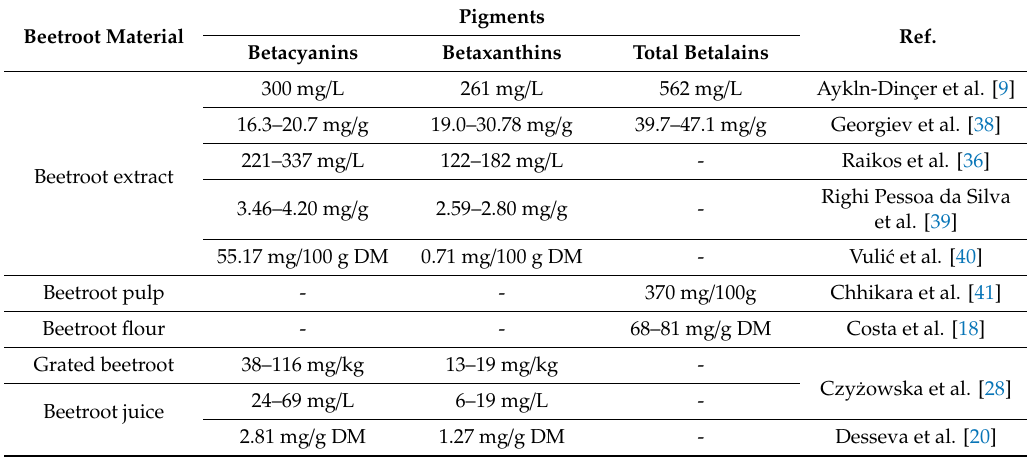
Table 1. Content of total betalains, betacyanins, and betaxanthins in di ff erent beetroot